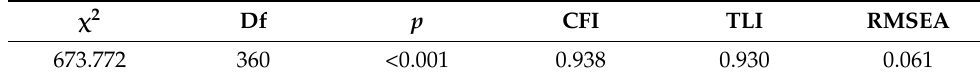
Table 6. Validity of the structural equation